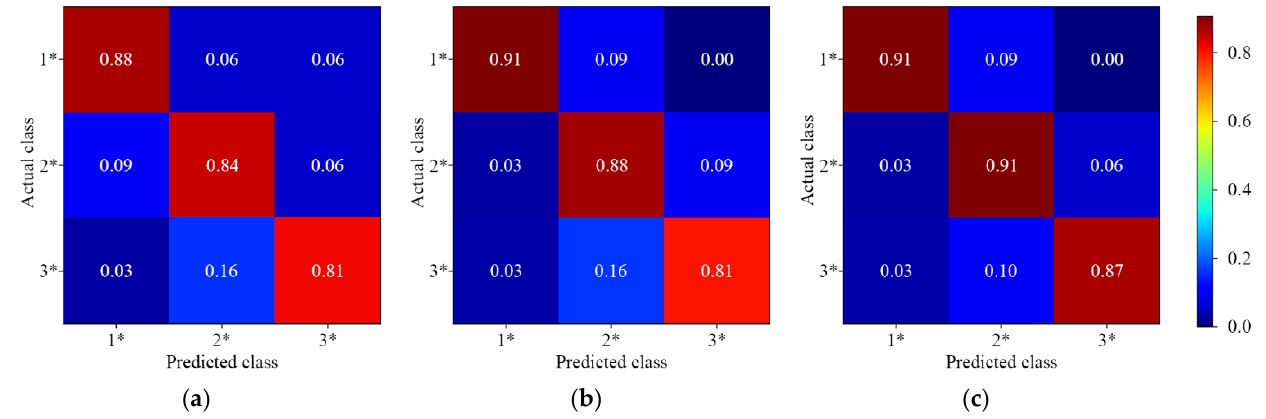
Figure 9. The normalized confusion matrix for three-level discrimination of beta-cypermethrin residues. ( a ) Single-depth 1D-CNN; ( b ) Symmetric multiscale 1D-CNN; ( c ) Asymmetric multiscale 1D-CNN.